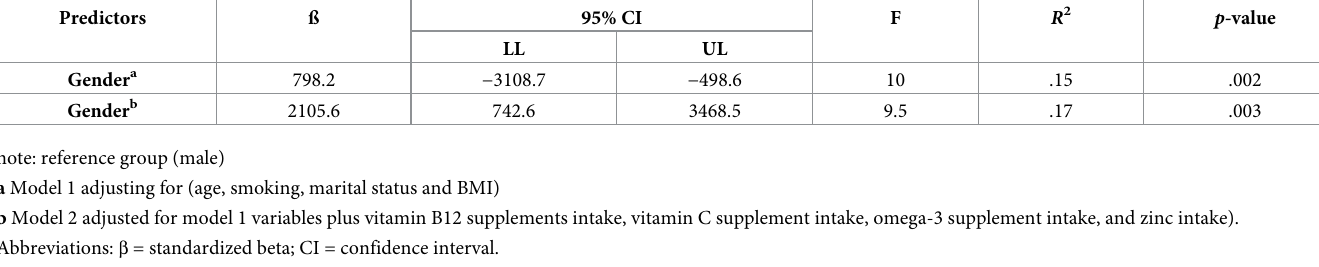
Table 4. Multiple linear regression analysis to assess the association of fatigue severity with gender as an independent variable.